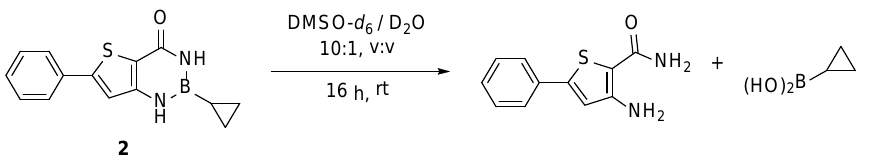
Figure 3. Evolution of the NMR signals of compound 3 before and after addition of D 2 O.